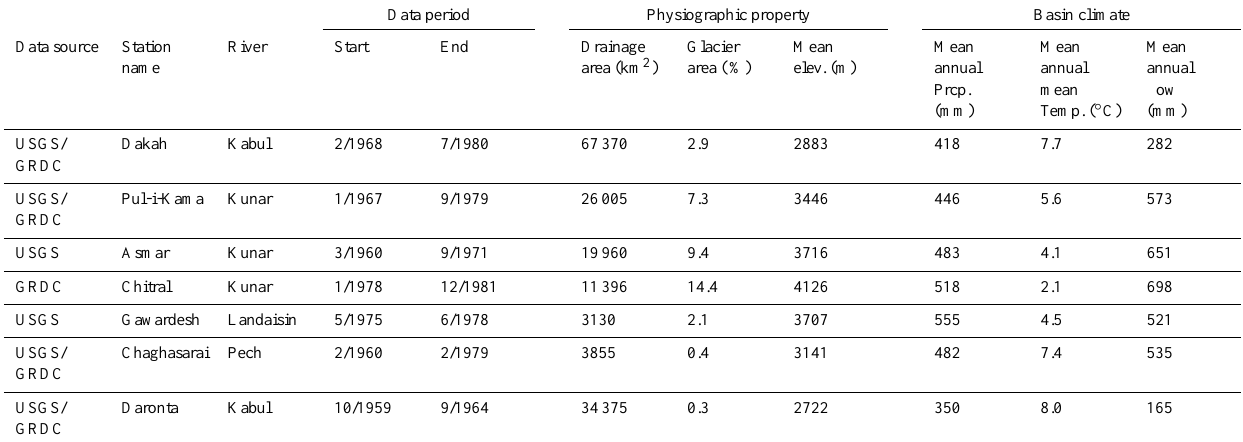
Table 1. Streamflow gaging stations in the Kabul River